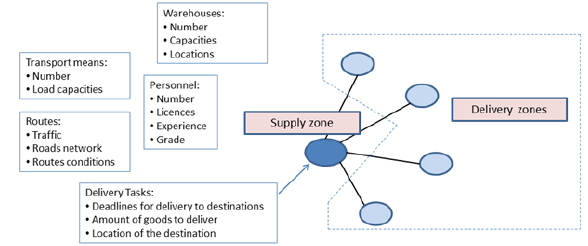
Fig. 1. Typical model of a delivery scheduling system